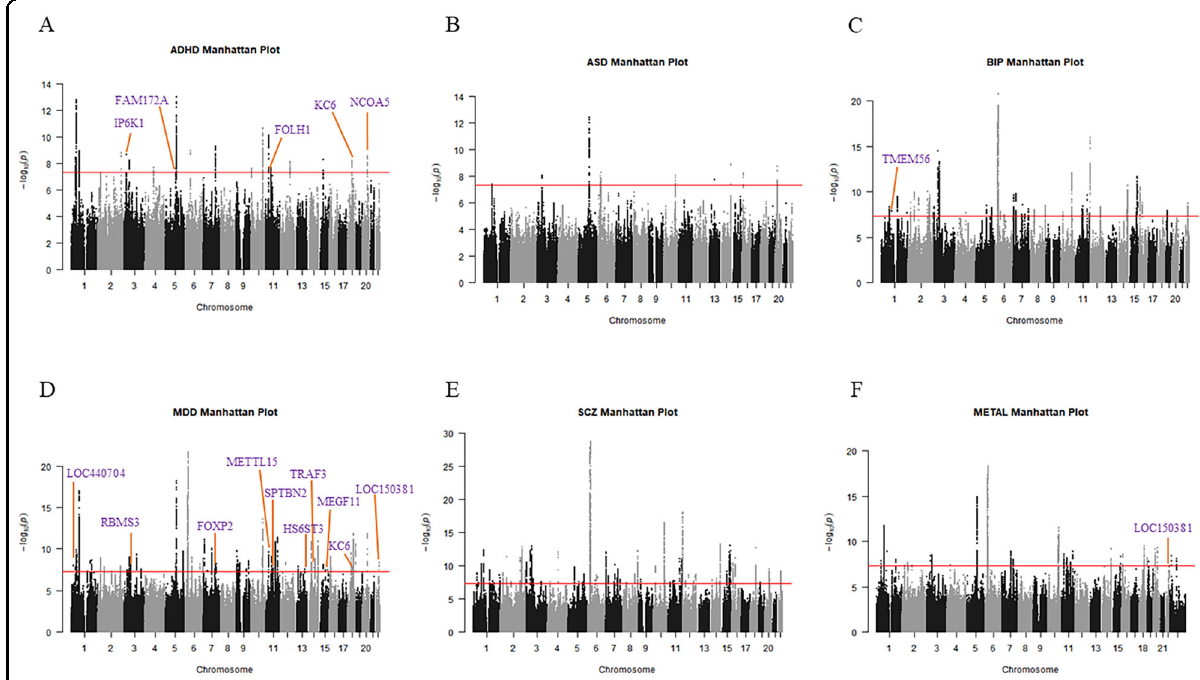
Fig. 1 Manhattan plots showing the association statistics for multi-trait joint analysis and meta-analysis of fi ve neuropsychiatric diseases. Manhattan plots of the susceptibility loci of fi ve neuropsychiatric diseases: ADHD ( A ), ASD ( B ), BIP ( C ), MDD ( D ), SCZ ( E ), METAL ( F ). SNP locations are plotted on the x -axis according to their chromosomal position. The y -axis shows the − log 10 of P values per SNP derived from the meta-analysis. The horizontal red line represents the genome-wide signi fi cance threshold of P value < 5 × 10 − 8 . The purple text shows the closest gene to the most prominent SNPs at each novel locus.